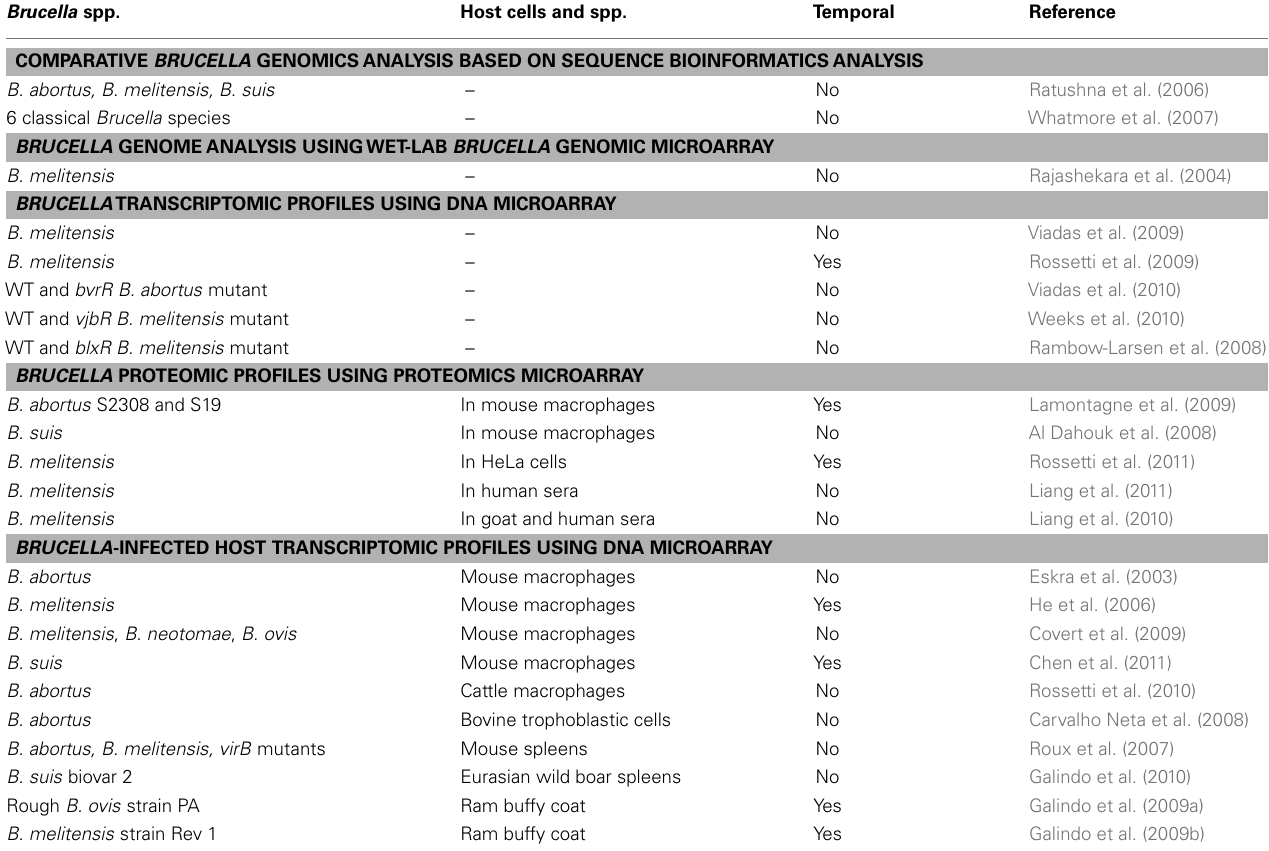
Table 1 | Reviewed omics studies in Brucella pathogenesis and host immunity. Brucella